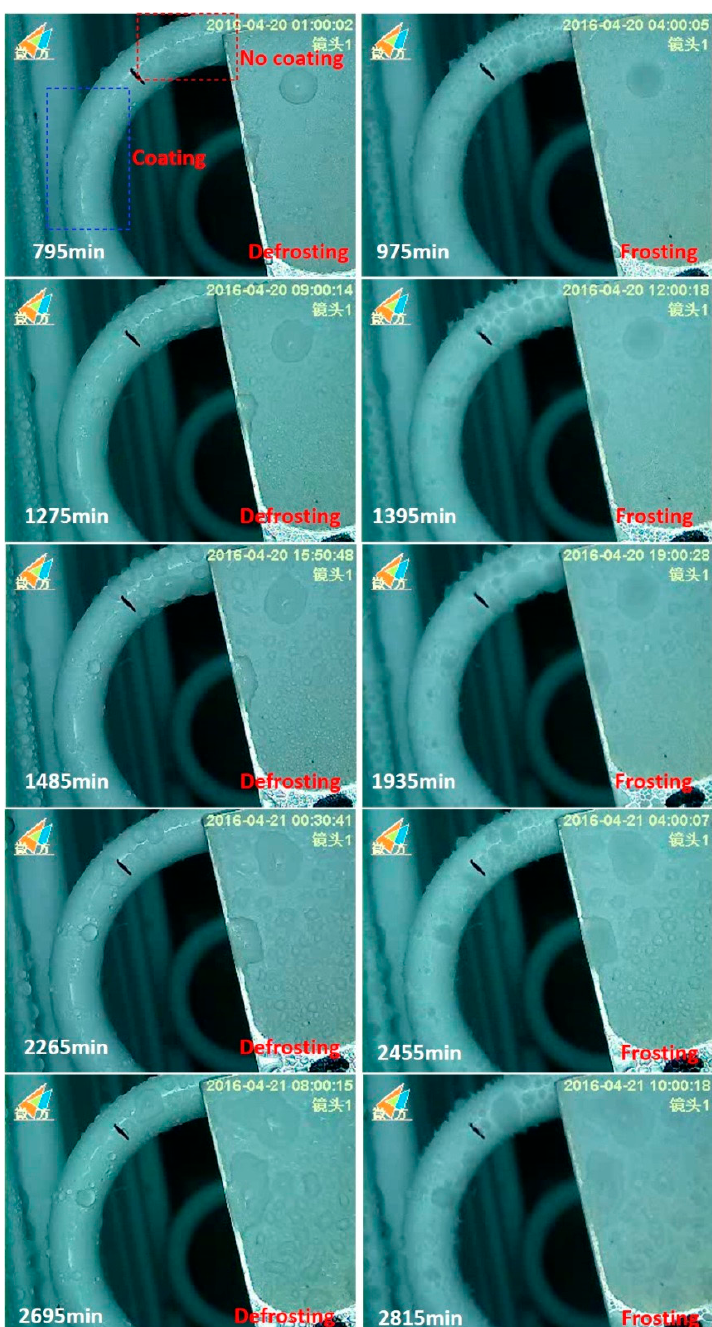
Figure 11. Frosting and defrosting cycles with time on the surface of the evaporator pipe without and with the PDMS-SiO 2 /PFA hybrid